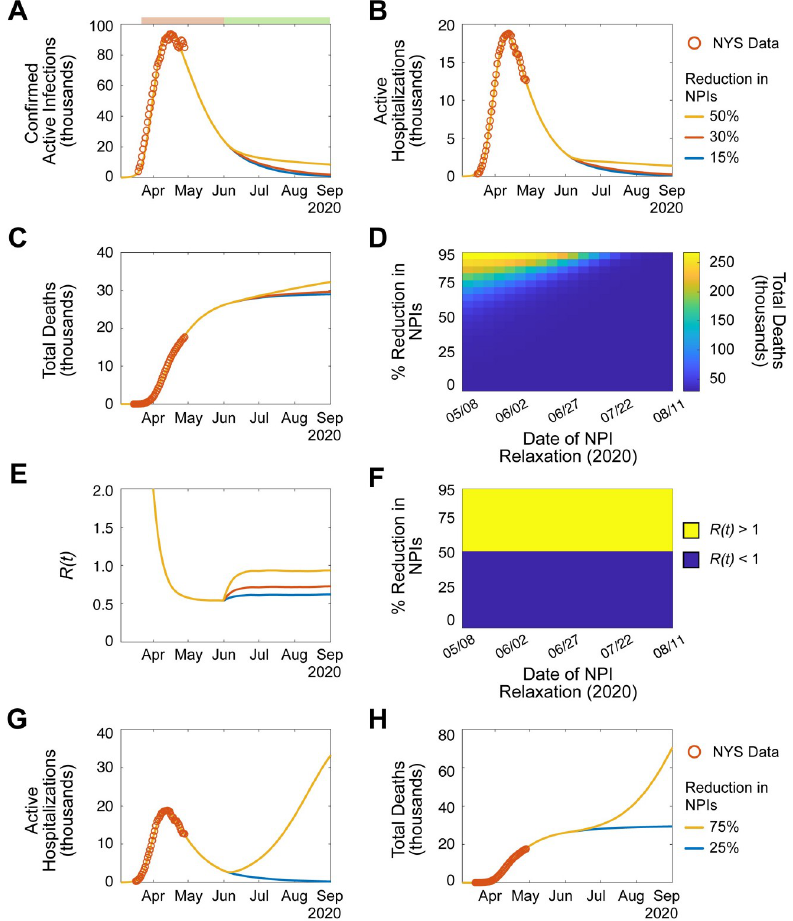
Fig 2. Reduction of NPIs by > 50% may result increased transmission and significant mortality. ( A-F ). Simulation of SARS-CoV-2 transmission dynamics in the presence of NPIs through September 1, 2020. Periods of NPIs signified as in (A) top: pink, increased NPIs; green, relaxed NPIs. Orange circles, NYS SARS-CoV-2 data. Lines, simulated projection of reduced NPIs starting June 1, 2020 (yellow, 50% reduction; red, 30% reduction; blue, 15% reduction). A. Active confirmed infections. B. Active hospitalizations. C. Cumulative deaths. D. Heatmap displaying the effect of NPI magnitude and date of reduction on the number of cumulative deaths. E . R(t) . F. Categorical heatmap displaying the effect of NPI magnitude and date of reduction on R(t) > 1 (yellow, R(t) > 1; blue R(t) < 1). ( G-H ). Simulation of extreme reduction of NPIs on June 1, 2020 (yellow, 75%; blue, 25%). G. Active hospitalizations. H. Cumulative deaths. See also, S7 and S8 Figs, S4